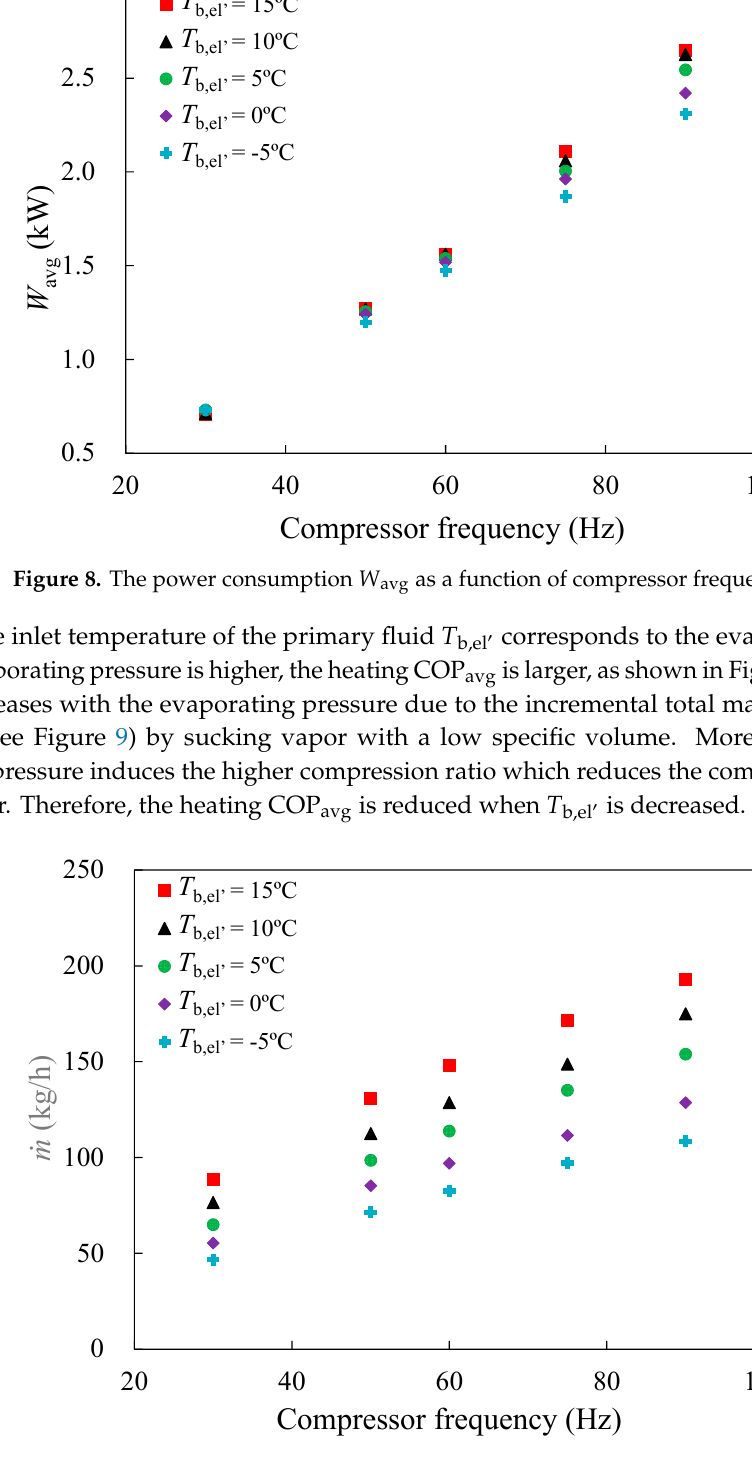
Figure 9 The mass flow rate of refrigerant ṁ as a function of compressor frequency